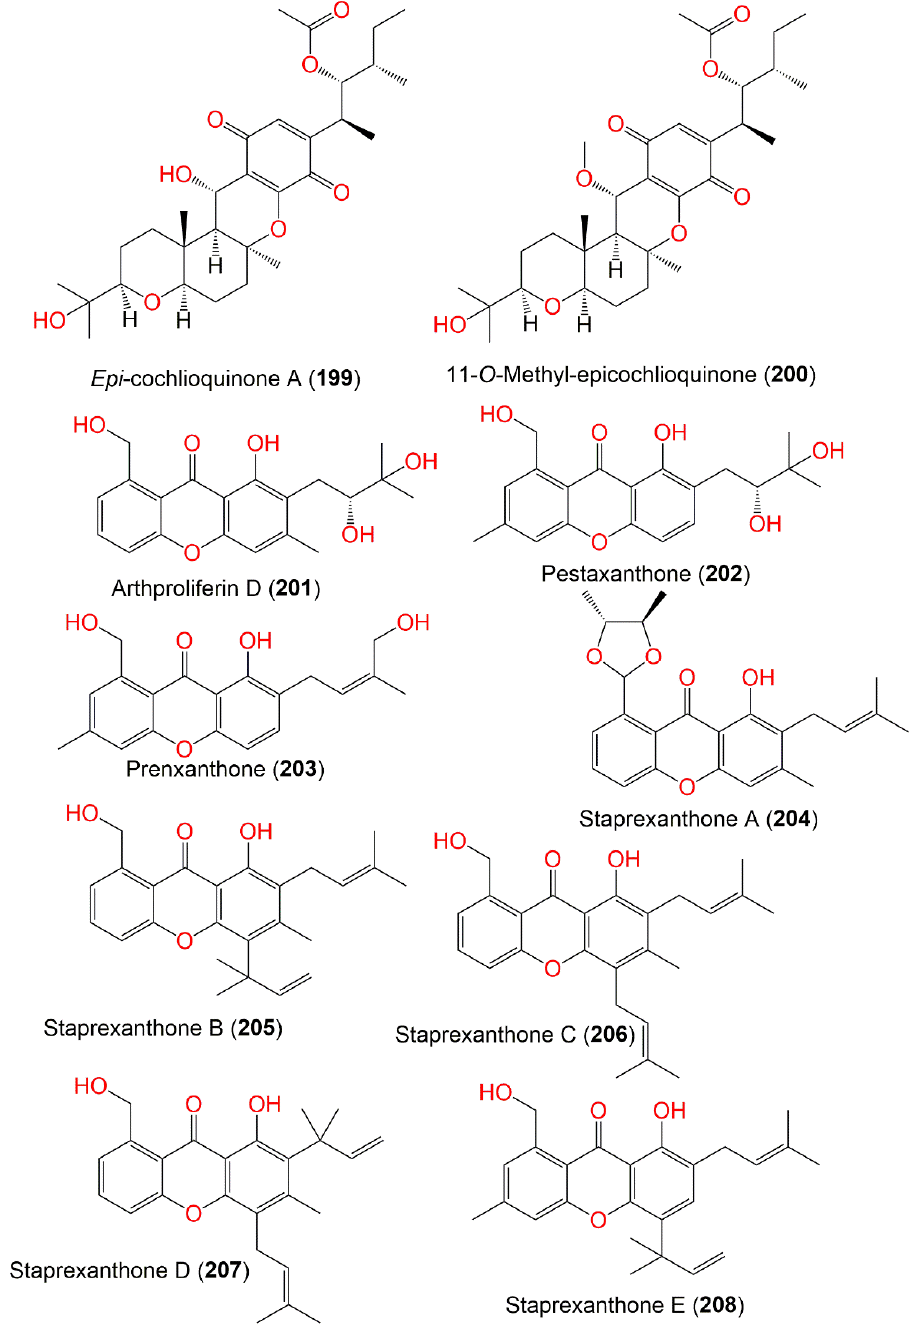
Figure 25. Structures of cochlioquinones ( 199 and 200 ) and xanthones ( 201 – 208 ) reported from S. chartarum